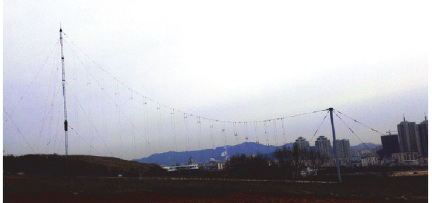
Figure 1: Transmitting antenna.